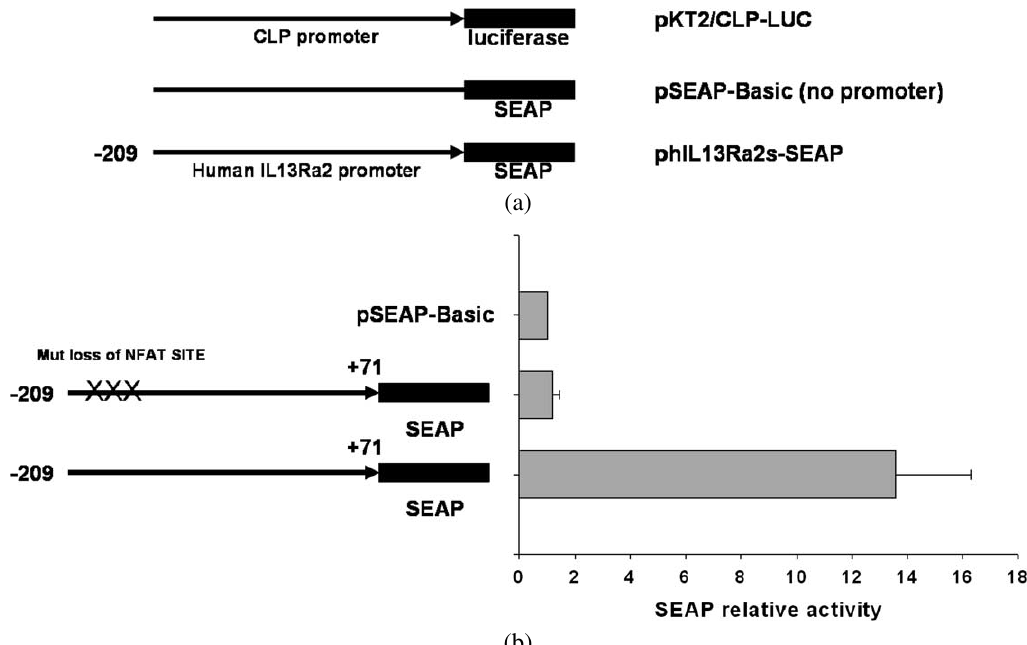
Fig. 2B. In vitro mutagenesis analysis. (a) Scheme of plasmids used. (b) Human glioma cell line U118 was transfected with various reporter gene constructs and assayed for SEAP activity. NFAT mutation is indicated. SEAP activity of every transfection was normalized with the luciferase activity by cotransfection of pKT2/CLP-luc plasmid, and relative to the basal SEAP activity obtained with the pSEAP basic plasmid. The column and bars represent the mean and standard deviation, respectively. All the values were obtained from 3 independent